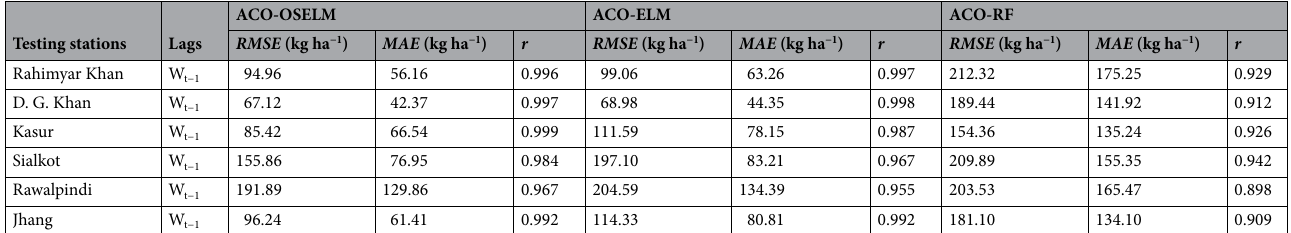
Table 6. Testing performance of ACO-OSELM versus ACO-ELM and ACO-RF models measured by root mean square error ( RMSE ), mean absolute error ( MAE ), coefficient of determination ( r